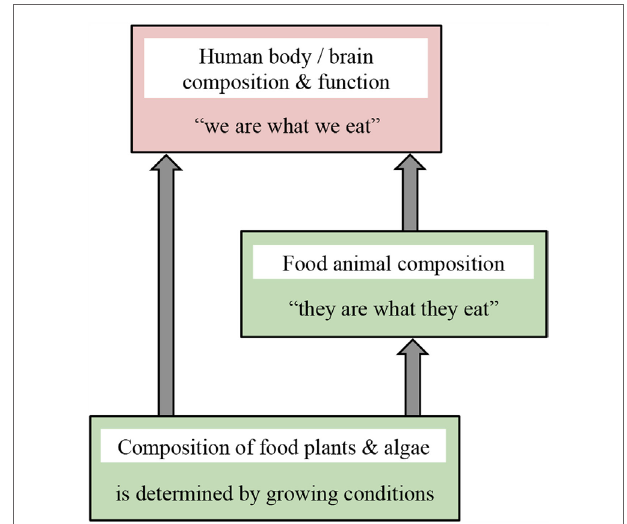
FiguRe 1 | Schematic depiction of the message that growing conditions or what is eaten strongly impacts composition and function of living organisms . Crop composition is modulated by factors such as water and nutrient supply, body composition of livestock reflects their feed, and compo- sition and function of human body and brain are determined by what we eat.